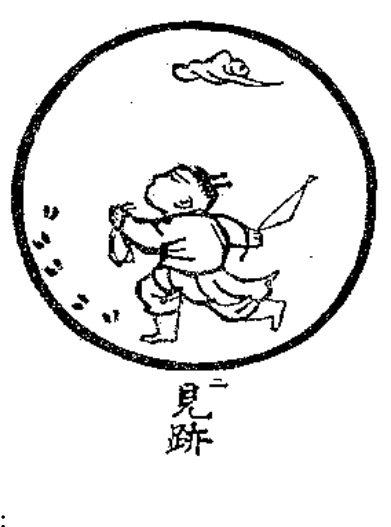
Figure 2. Discovering the